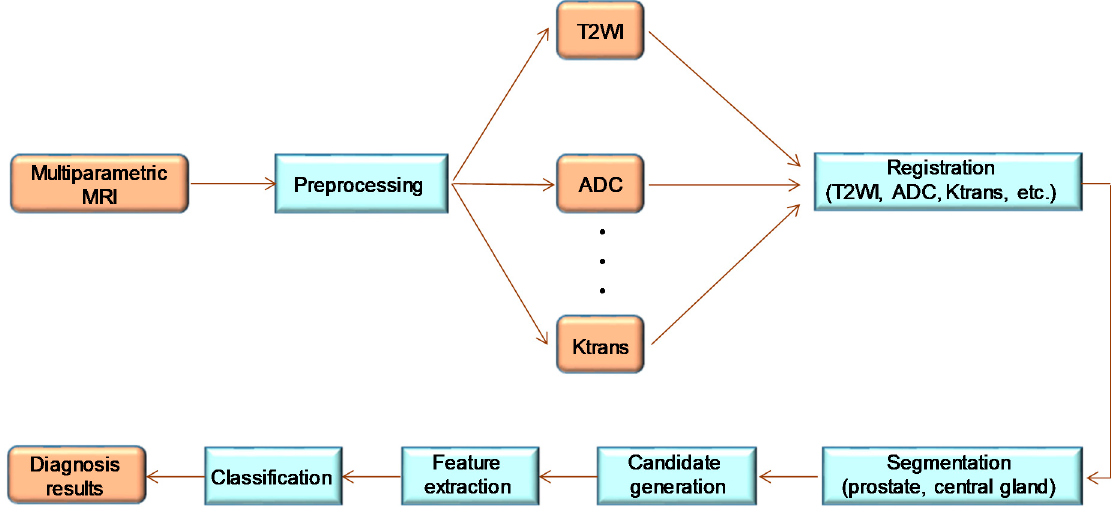
Figure 1. Workflow diagram of a typical prostate CADx system in Reference 44 (Wang et al., 2014); this is a modified figure from the reference. The orange squares indicate the data (original scan and pre-processed image), and the light blue squares indicate the data and processing applied to the image.